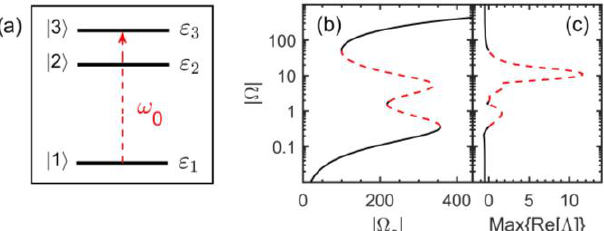
Fig. 1. (a) – Excitation scheme of a QE (Δ 31 = 0). (b) – Steady-state solution for |Ω| as function of |Ω 0 |. Solid (dashed) parts of the curves indicate stable (unstable) regions of |Ω|. (c) – Real part of the major Lyapunov exponent Max{Re[Λ]} as a function of |Ω|. Parameters of calculations are: Δ 32 = 10,